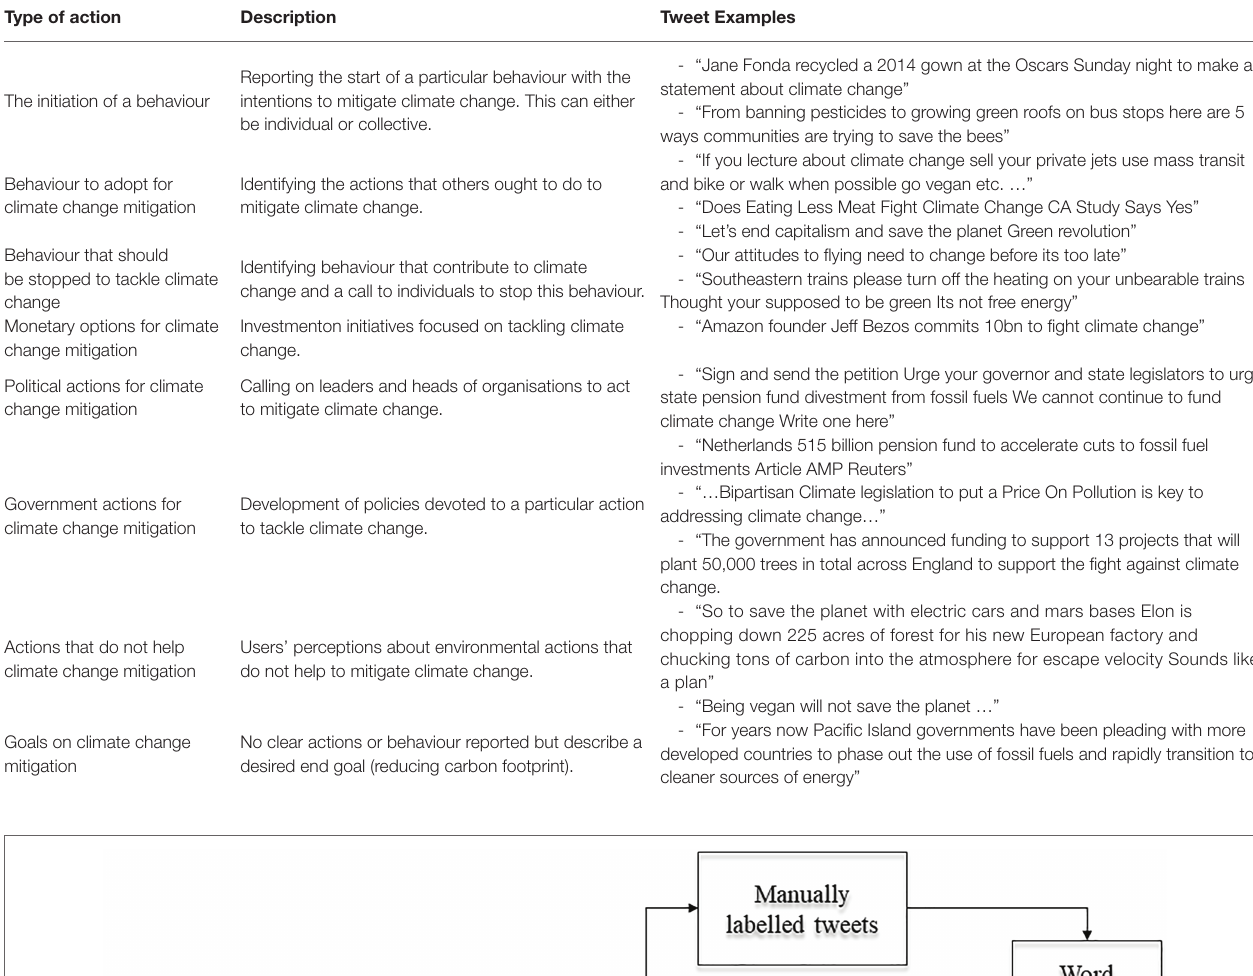
TABLE 1 | Description of the types of actions considered for the classification of “action tweets.”